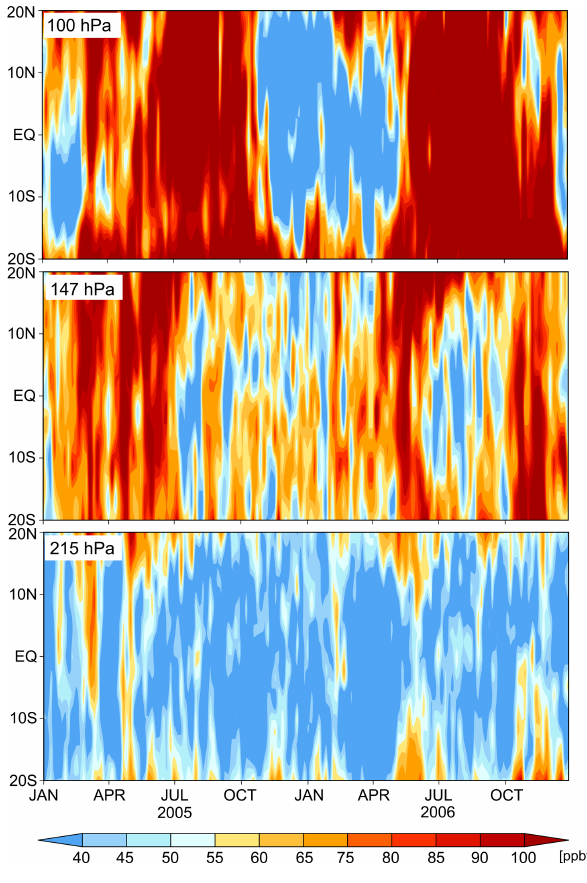
Fig. 4. Same as Fig. 2, but for O 3